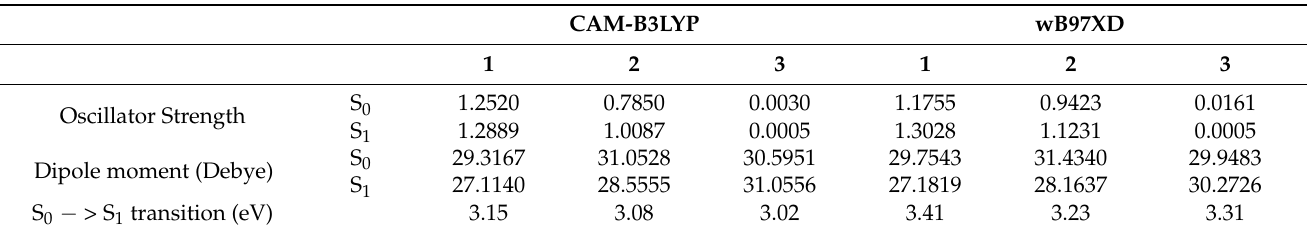
Table 2. Oscillator strength and dipole moments of compounds 1 , 2 , and 3 in the ground and excited-state calculated using CAM-B3LYP and wB97XD functionals. S 0 − > S 1 transitions are reported for ground state geometries.